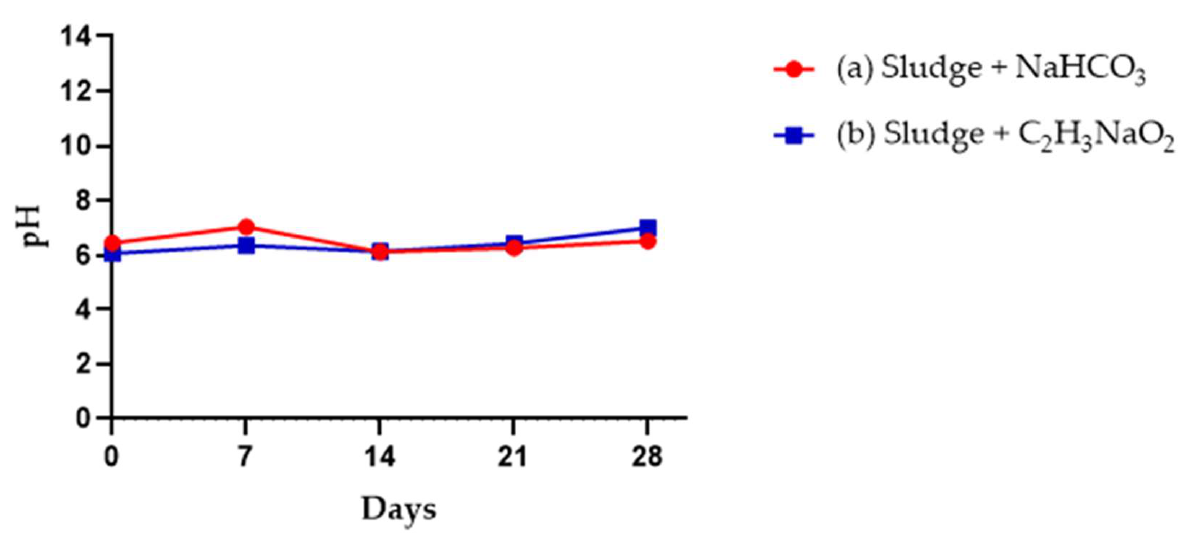
Figure 4. Evolution of the pH of the enriched sludge samples .